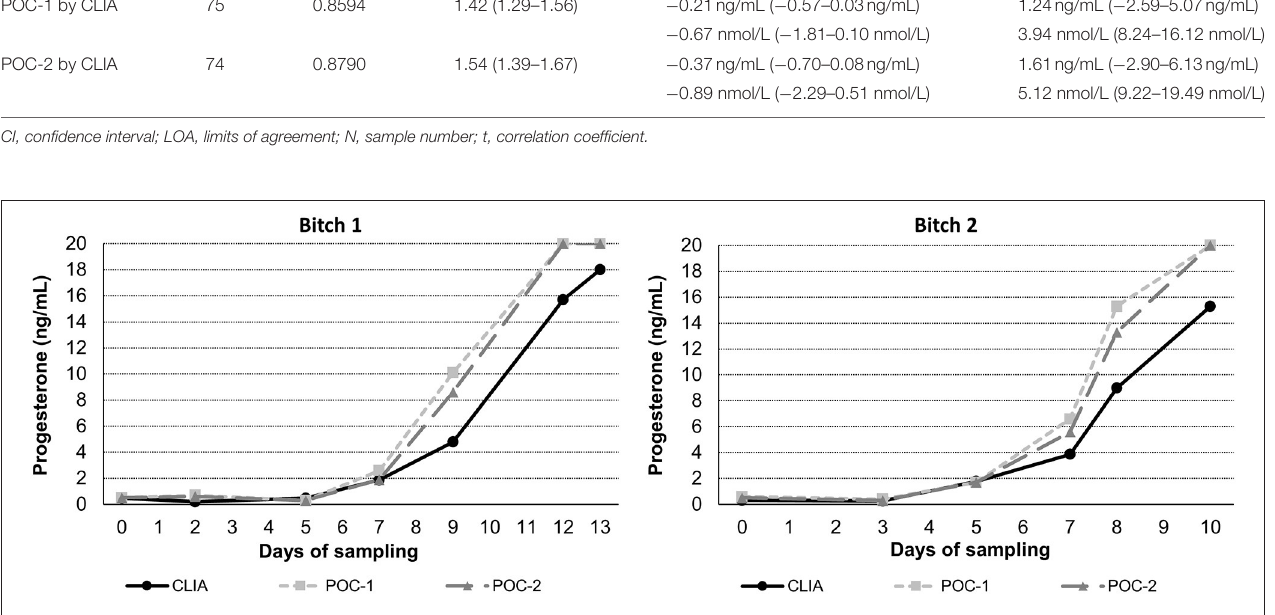
FIGURE 2 | Representative serum progesterone curves measured by the reference chemiluminescent immunoassay (CLIA) and two point-of-care analyzers (POC-1 and POC-2) from two individual bitches during breeding management. Day 0 is the day blood sampling started, which corresponded to day 5–7 from the first day of proestrus. Progesterone concentrations above the upper limit of detection of the POC (20ng/mL) are depicted as